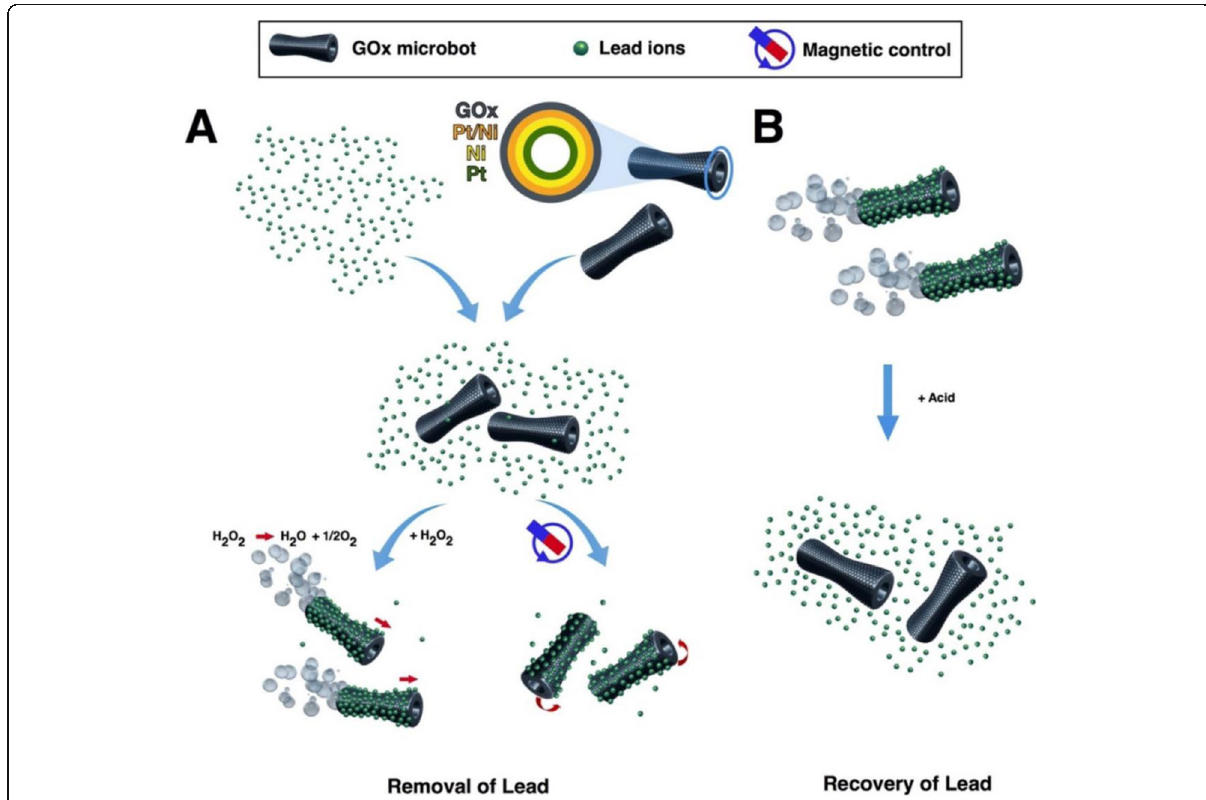
Fig. 5 Scheme of GOx-microbot-based approach for lead decontamination and recovery. a Decontamination of polluted water using GOx- microbots fabricated by electrodeposition of nanolayers of graphene oxide (GOx), Pt/Ni layer, Ni magnetic layer, and Pt catalytic inner layer. The decontamination strategy for lead ions can be carried out by two different techniques: self-propulsion of the GOx-microbots in the presence of H 2 O 2 or by using an external rotating magnetic field. b Recovery of lead ions from the GOx-microbots in the presence of acidic media